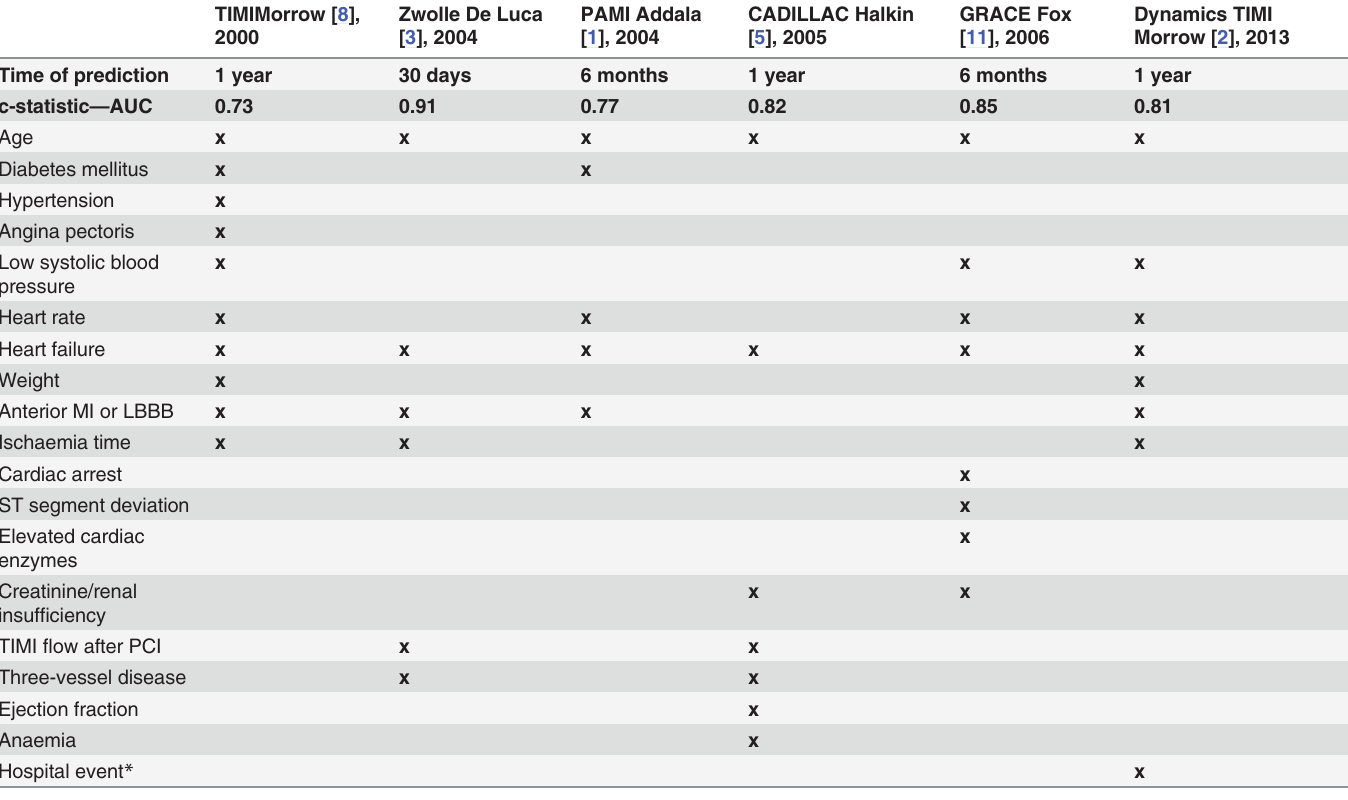
Table 1. Risk-scoring models and their